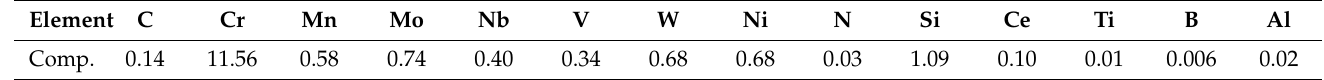
Table 1. Elemental composition of EP-823 steel, Fe—base, wt.